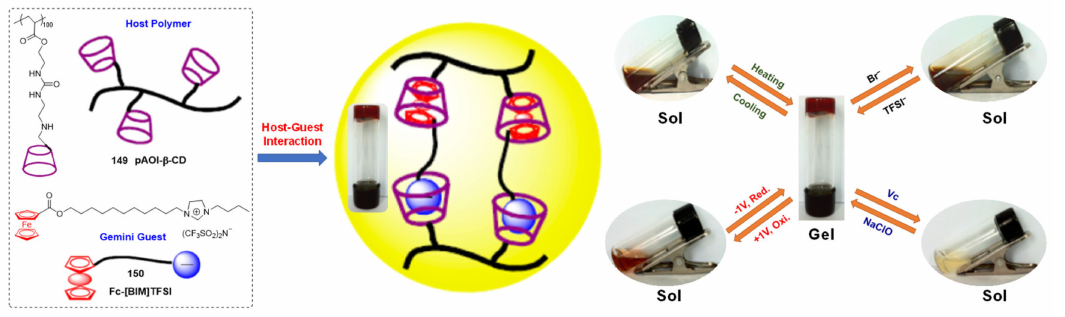
Figure 57. Preparation of ionic liquid gemini guest cross-linked electroactive supramolecular gels and their assembly and disassembly, induced by multi-stimuli. Reprinted with permission from Ref. [140]. Copyright (2014), American Chemical